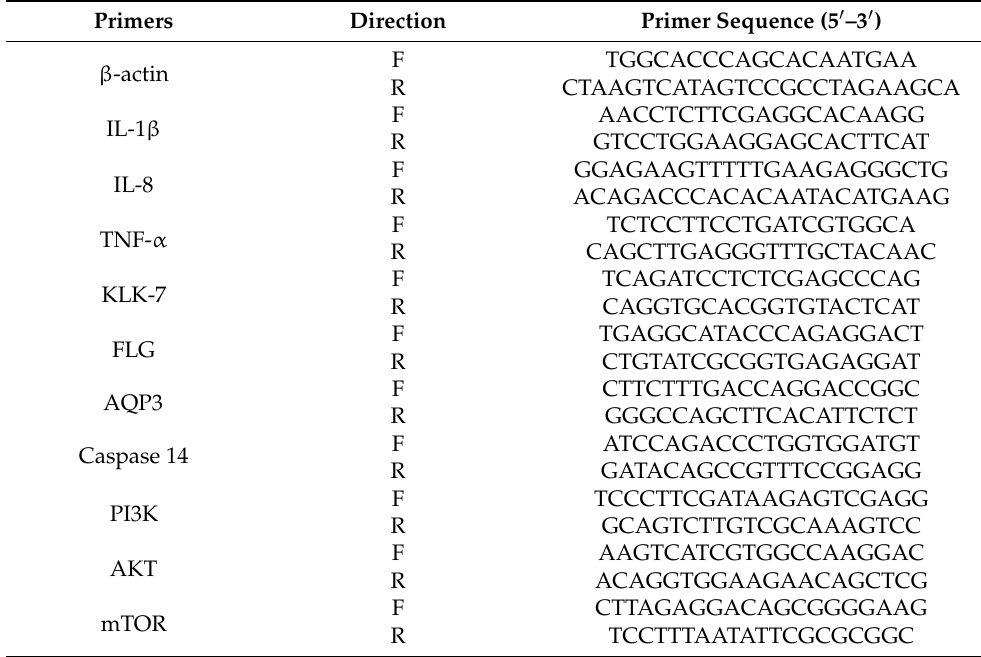
Table 1. Primers. Primers